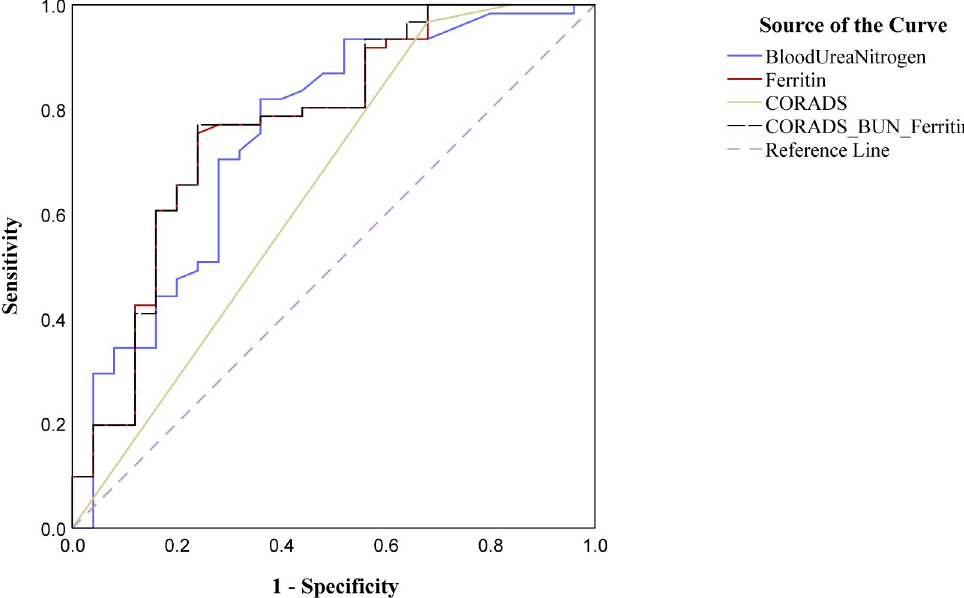
Fig 5. Receiver operative characteristic curve plotted for CO-RADS, blood urea nitrogen and ferritin across the COVID-19 positive patients. ICU admission is considered as positive actual state. The line with combination of CO-RADS, Blood urea nitrogen, and Ferritin showed the best fit among all the parameters tested.